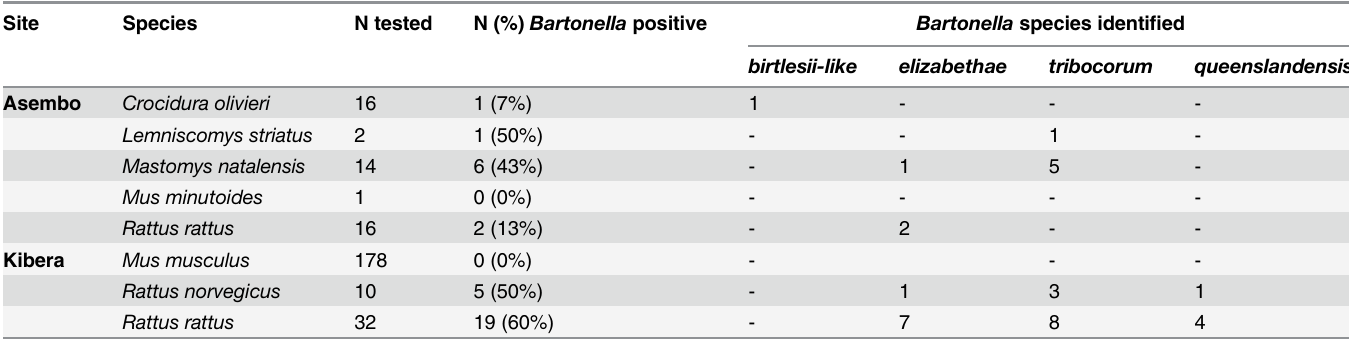
Table 2. Summary of the number and species of the Bartonella isolates obtained and the prevalence of Bartonella infection in each population. Site